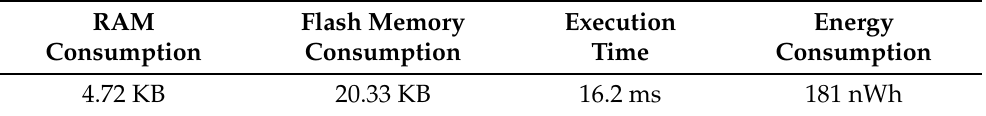
Table 4. Measurement values of the implemented solution executed in nRF52840